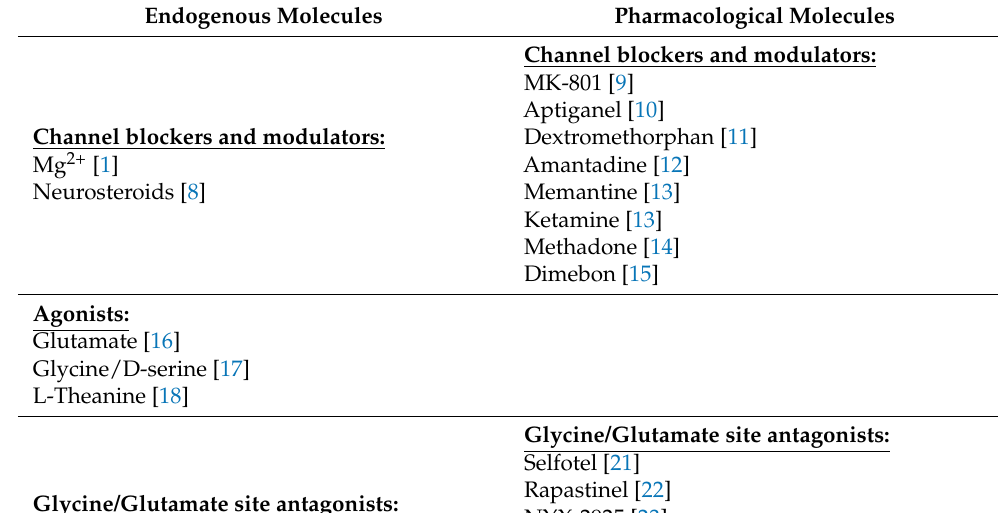
Table 1. Classification of endogenous and pharmacological molecules targeting